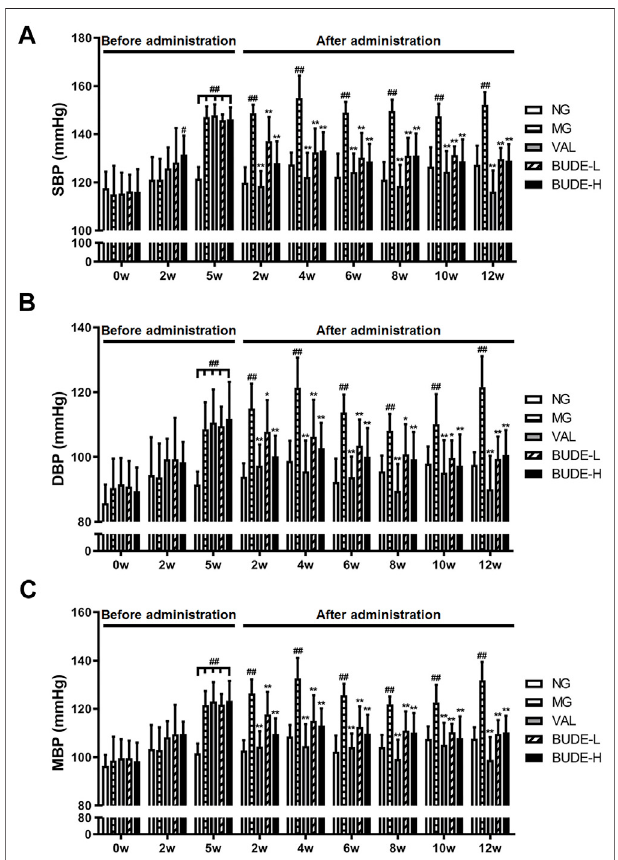
FIGURE 2 | Effect of BUDE on the blood pressure of the model rats. (A) Changes in the systolic blood pressure (SBP). (B) Changes in the diastolic blood pressure (DBP). (C) Changes in the mean blood pressure (MBP). Compared with the normal control group # p < 0.05, ## p < 0.01; compared with the model control group * p < 0.05, ** p < 0.01, n (cid:2) 8 – 10. NG: normal control group; MG: ACHSFDs model group; VAL: valsartan group; BUDE-L: BUDE low-dose group; BUDE-H: BUDE high-dose group.